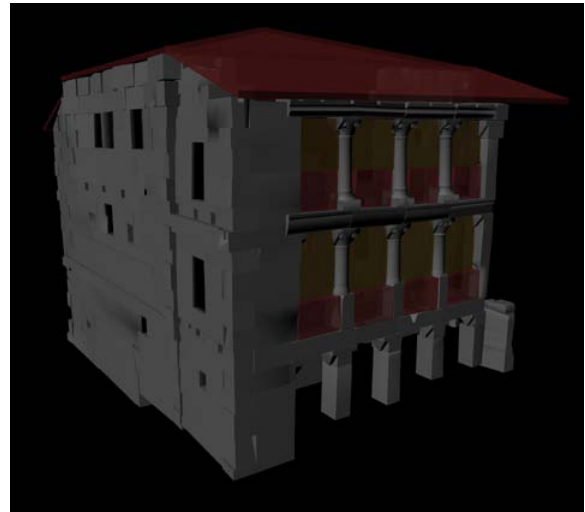
Figure 22. The anastylosis of the